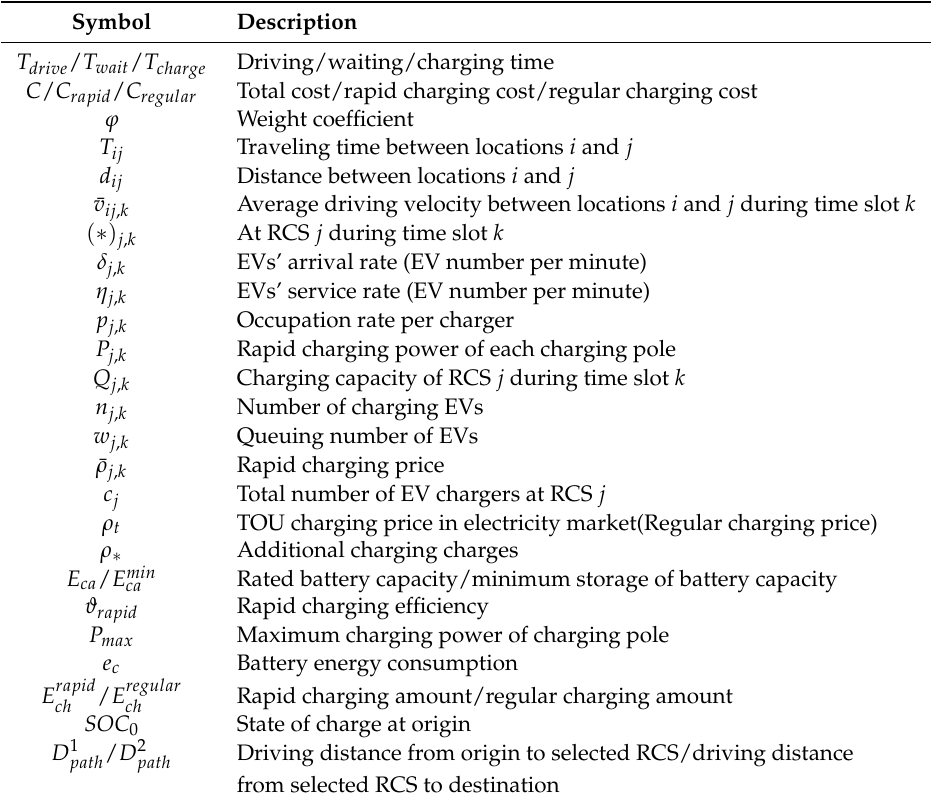
Table 1. Mathematical symbols used in this